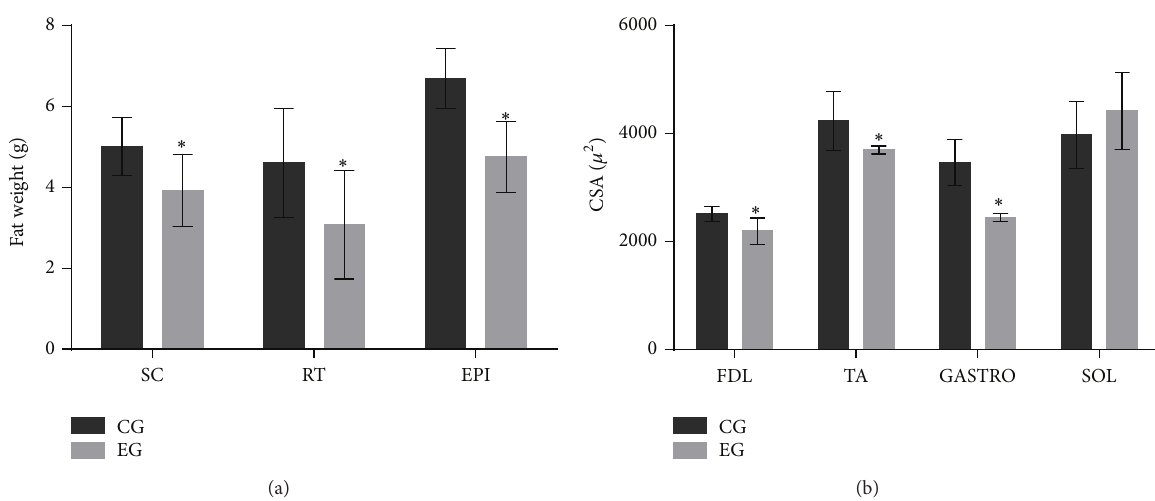
Figure 3: (a) Weight of subcutaneous (SC), retroperitoneal (RT), and epididymal (EPI) fat pads and (b) cross-sectional area (CSA) of the Flexor Digitorum Longus (FDL), Tibialis Anterior (TA), Gastrocnemius (GASTRO), and Soleus (SOL) muscles. The data are shown as mean ± standard deviation; statistical significance was accepted at 𝑃 < 0.05 . ( ∗ ) Difference between the EG and CG.